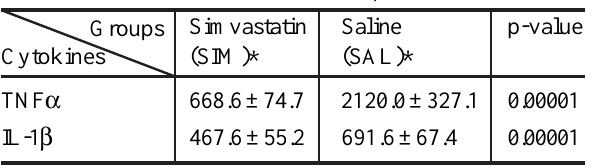
FIGURE 1 - Mean areas corresponding to the expression of TNF α Significant difference comparing the groups simvastatin and saline (p<0.05). TABLE 1 - Mean and statistical analysis of optical density related to the expression of cytokines in tissues of skin infected wounds treated with simvastatin and saline